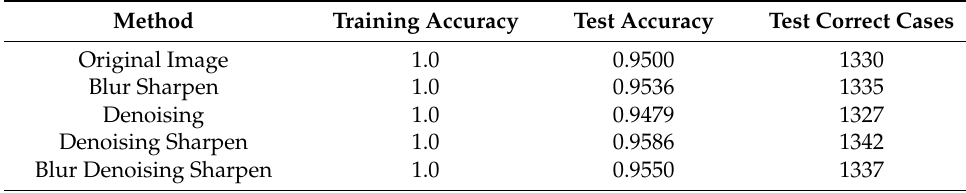
Table 2. Effect of image denoising methods on RSSCN7